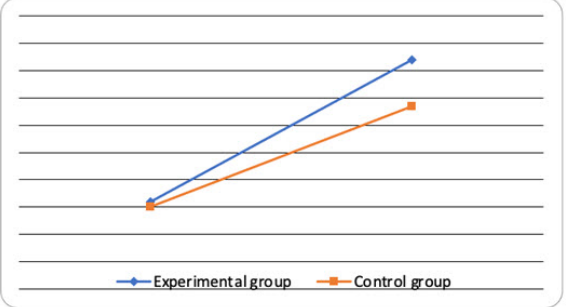
Chart 2. Comparison of the average values of communicative skills of the experimental and control